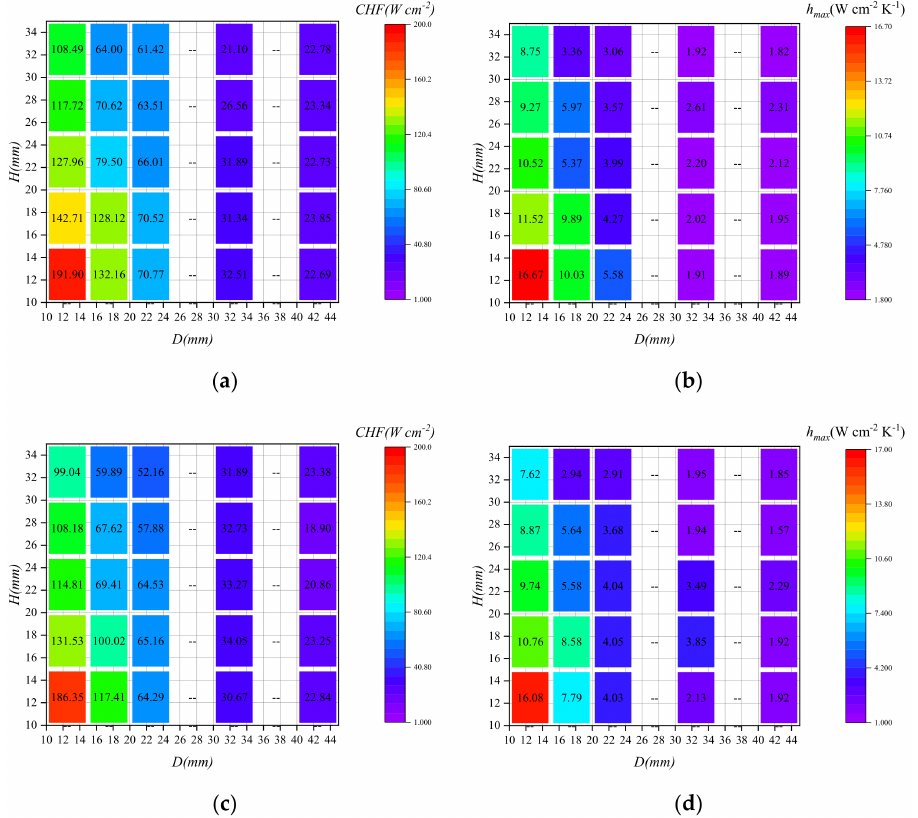
Figure 11. Thermodynamic diagrams of the distributions of CHF and h max at different mass flow rates. ( a ) Thermodynamic diagram of CHF distribution at high mass flow rate; ( b ) Thermodynamic diagram of h max distribution at high mass flow rate; ( c ) Thermodynamic diagram of CHF distribution at low mass flow rate; ( d ) Thermodynamic diagram of h max distribution at low mass flow